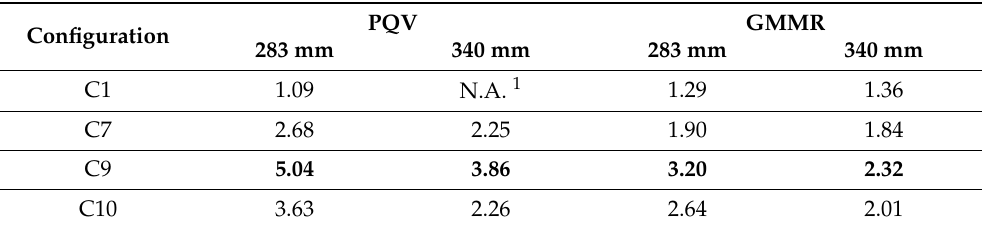
Table 4. Averaged PQV and GMMR of the first resonance for configurations 1, 7, 9, and 10 for pipes with lengths of 283 and 340 mm.